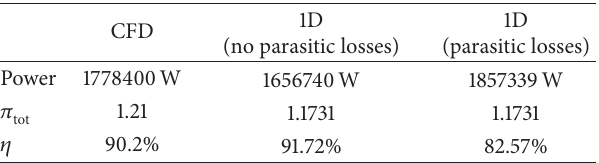
Table 3: Performance comparison between CFD and 1D code at design